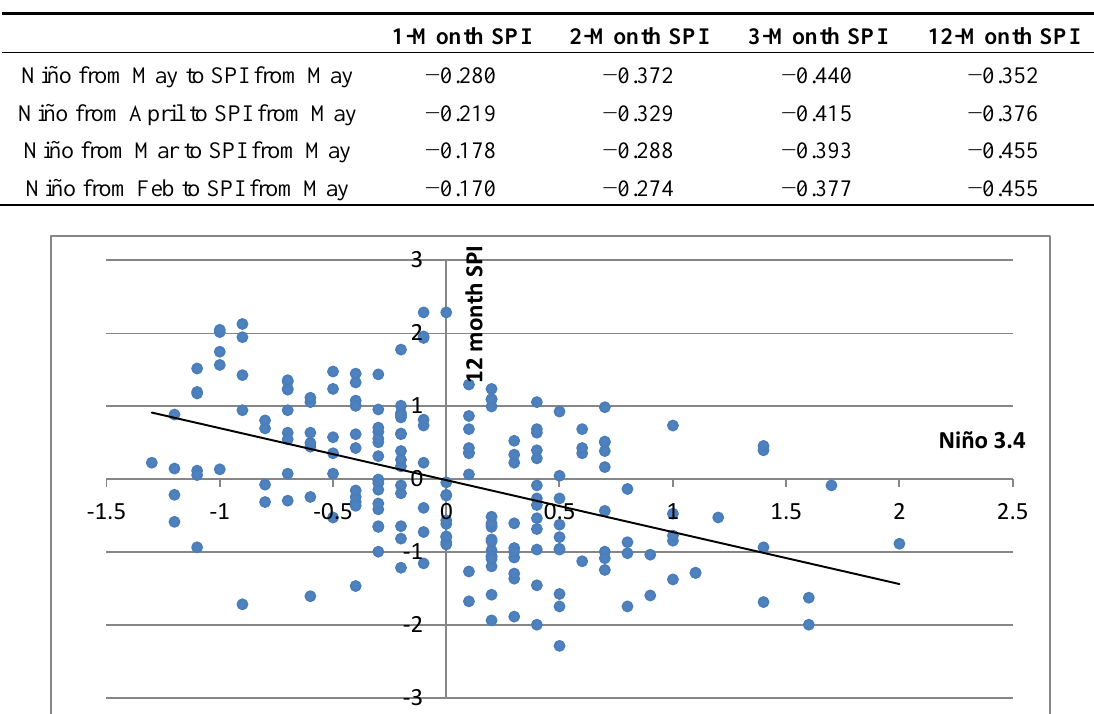
Table 5. Correlation Coefficient values for SPI-defined drought at Kampong Speu station and Niño 3.4. All values are significant at p = 0.90.